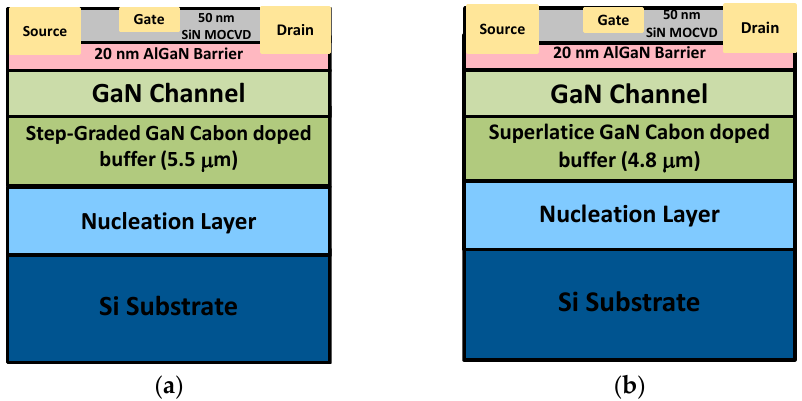
Figure 1. Schematic representation of the two tested samples. ( a ) The reference structure. ( b ) The superlattice-based structure.